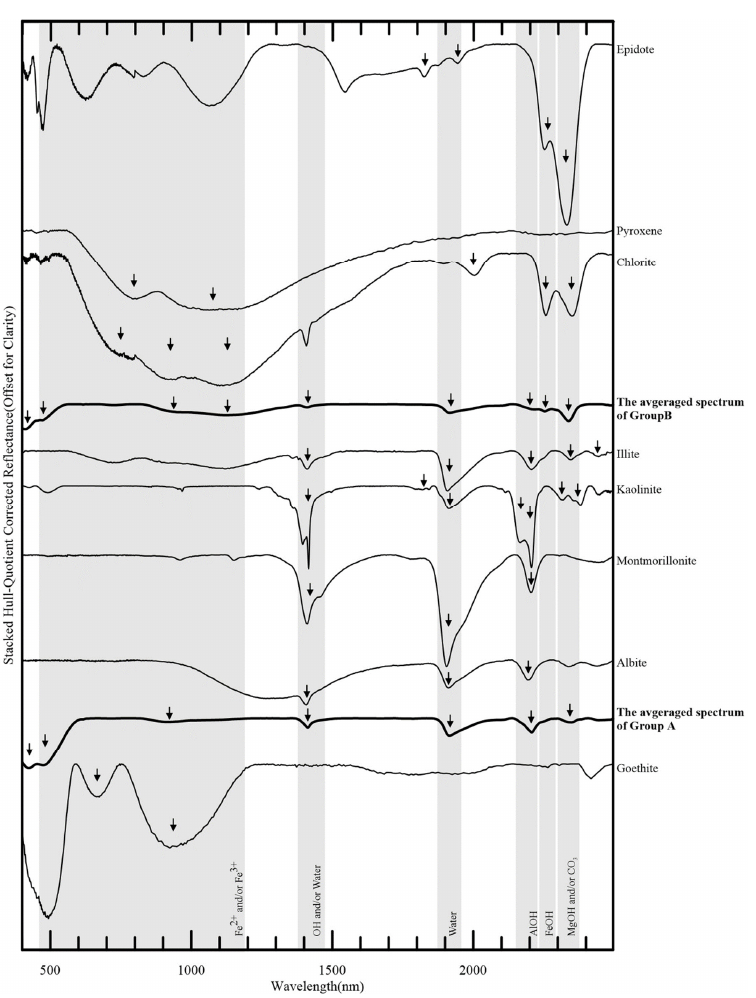
Figure 3. The average hull quotient spectra of Group A and B matched with epidote, pyroxene, chlorite, illite, kaolinite, montmorillonite, albite, and goethite. Remote Sens. 2020 , 12 , x FOR PEER REVIEW